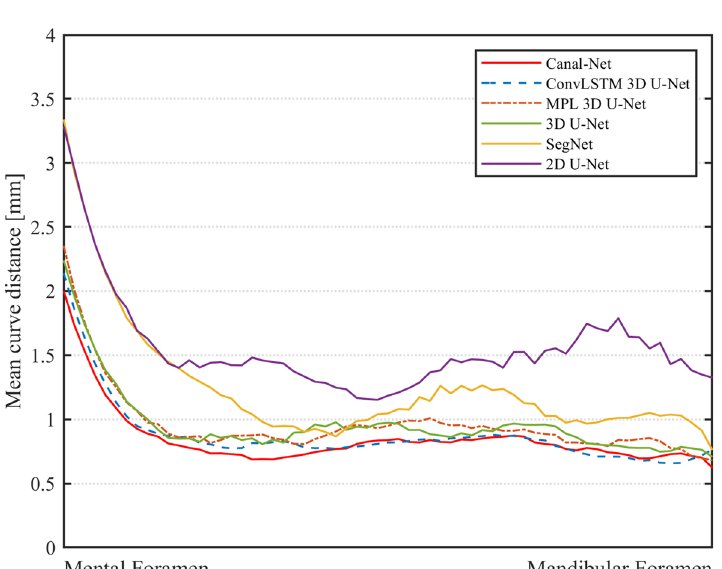
Figure 6. The line plots of mean curve distance (MCD) from the mental foramen to the mandibular foramen for Canal-Net (ours), ConvLSTM 3D U-Net (ours), MPL 3D U-Net (ours), 3D U-Net, SegNet, and 2D